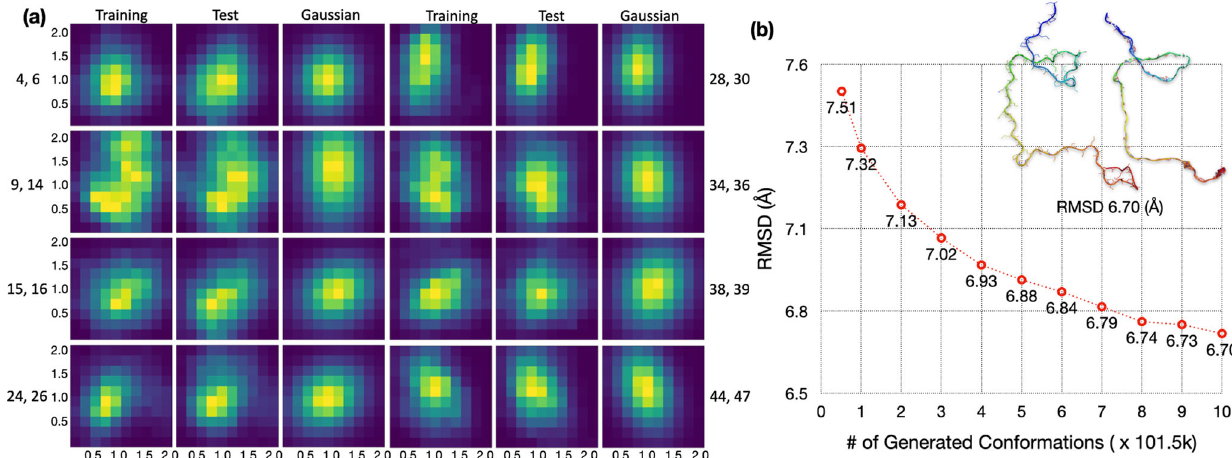
Fig. 5 Increased data overlap and prediction accuracy by combining MD runs of ChiZ. a Histograms in the latent space, shown as heat maps, with yellow representing pixels with the highest counts and dark blue representing pixels with 0 count. Histograms were calculated for pairs of nonzero elements, using 52,200, 121,800, and 101,500 vectors from the training and test sets and the multivariate Gaussian, respectively. The training and test sets were from combining conformations sampled in 12 MD runs; the multivariate Gaussian was parameterized on the combined training set. b The average best-match RMSDs of the 1000-fold diluted, combined test set against generated sets at different sizes. The autoencoder was trained on a 10-folded diluted, combined training set (size = 52,200) from all the 12 MD runs. The sizes of the generated sets are measured in multiples of the test size in a single MD run ( = 101,500), and range from 0.51× ( = training size) to 10×. The inset displays an IDP conformation and its generated best match, with an RMSD of the average value at